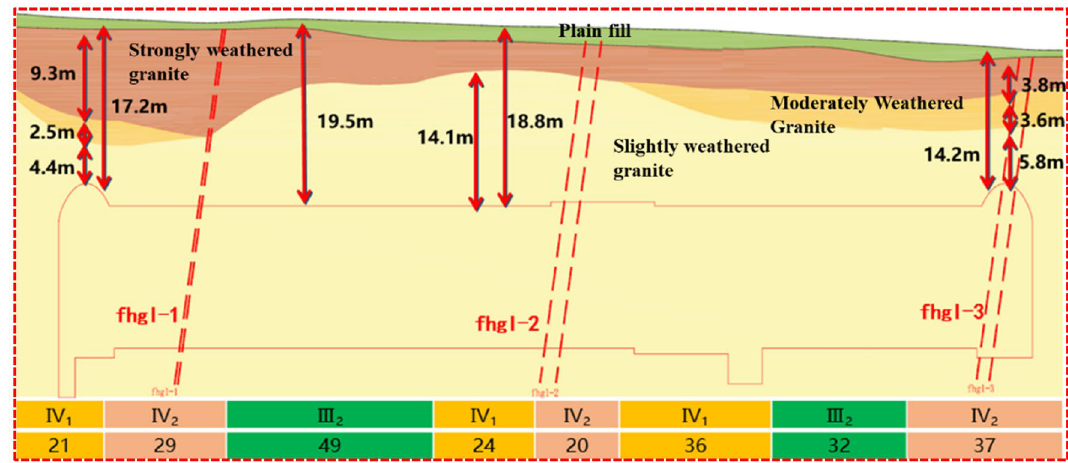
Figure 1. Geological date of underground excavation subway